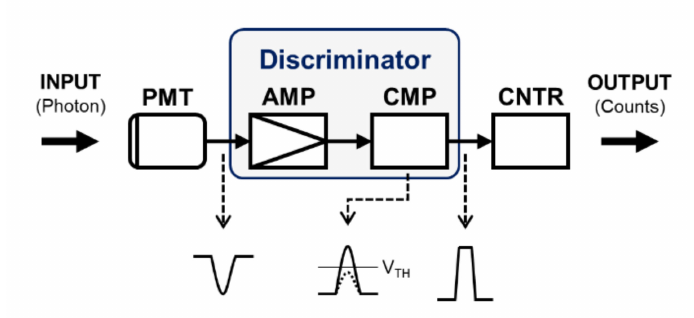
Figure 2. Configuration of the photon counter module. PMT: photomultiplier tube; AMP: amplifier; CMP: comparator; CNTR: